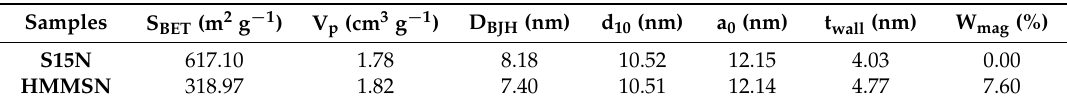
Table 1. Textural and structural values of the SBA-15 matrix and HMMSN hybrid magnetic nanocomposite. Surface area (S BET ), total pore volume (V p ), pore diameter (D BJH ), unit cell parameter